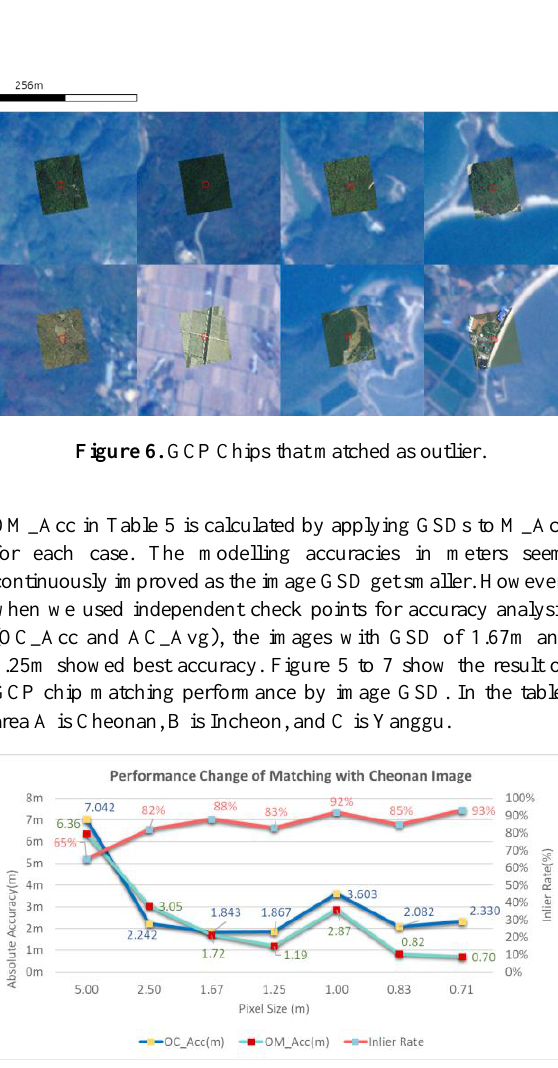
Figure 7. Performance change of matching with Cheonan RapidEye image.